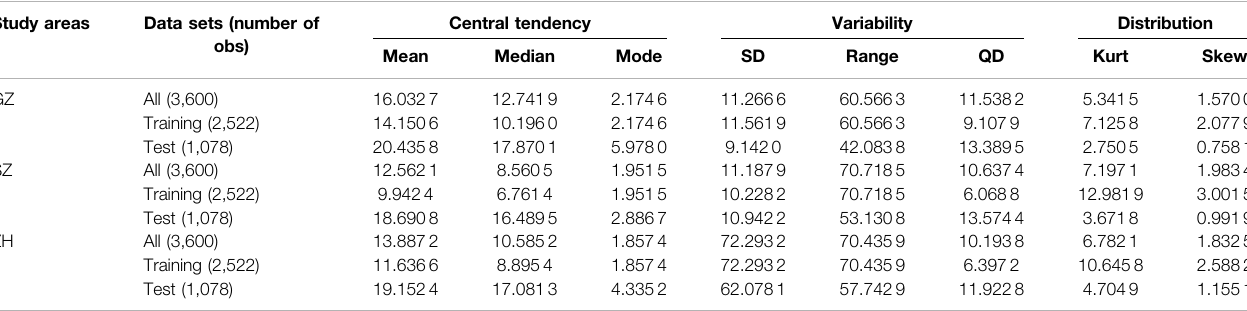
TABLE 4 | Descriptive statistics of data